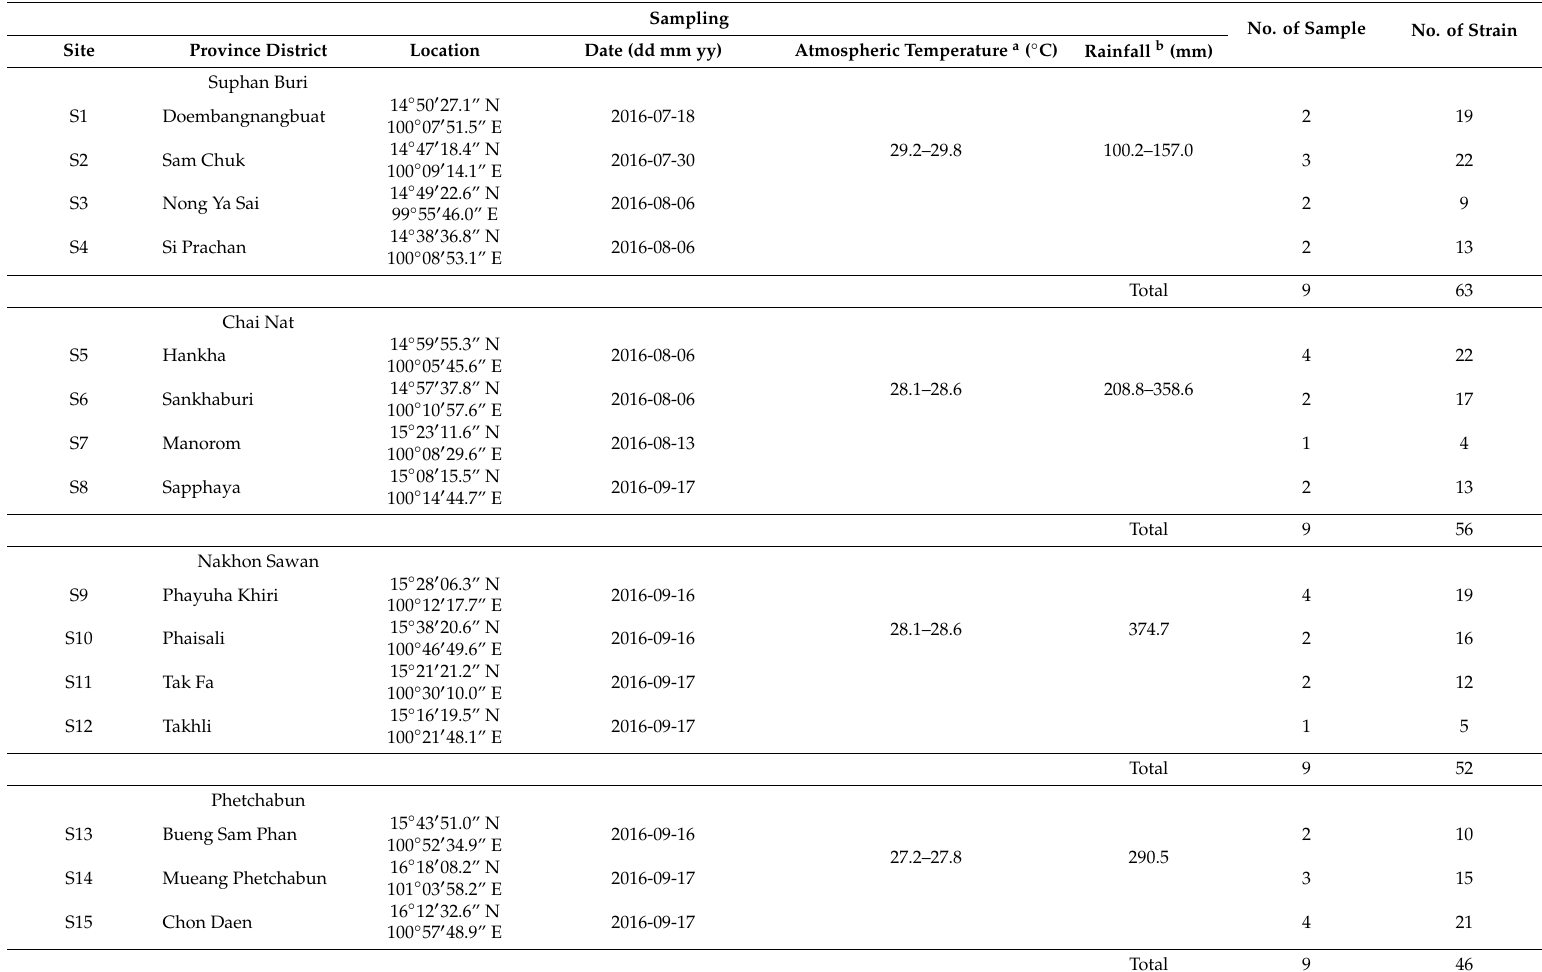
Table 1. Corn leaf samples and correspondent number of strains isolated during this